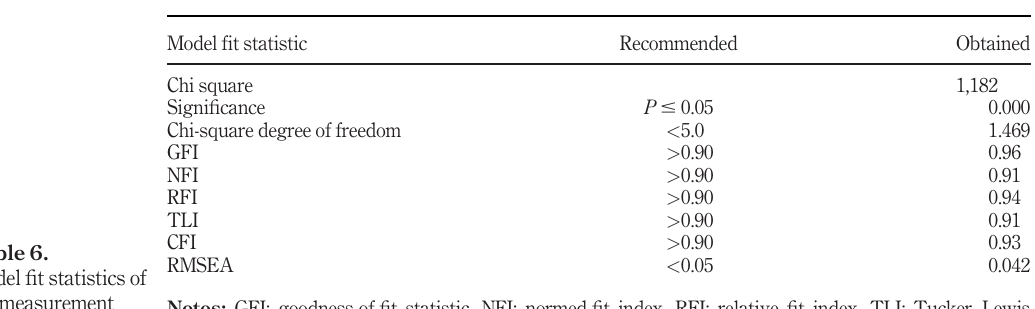
Table 5. Descriptive statistics analysis